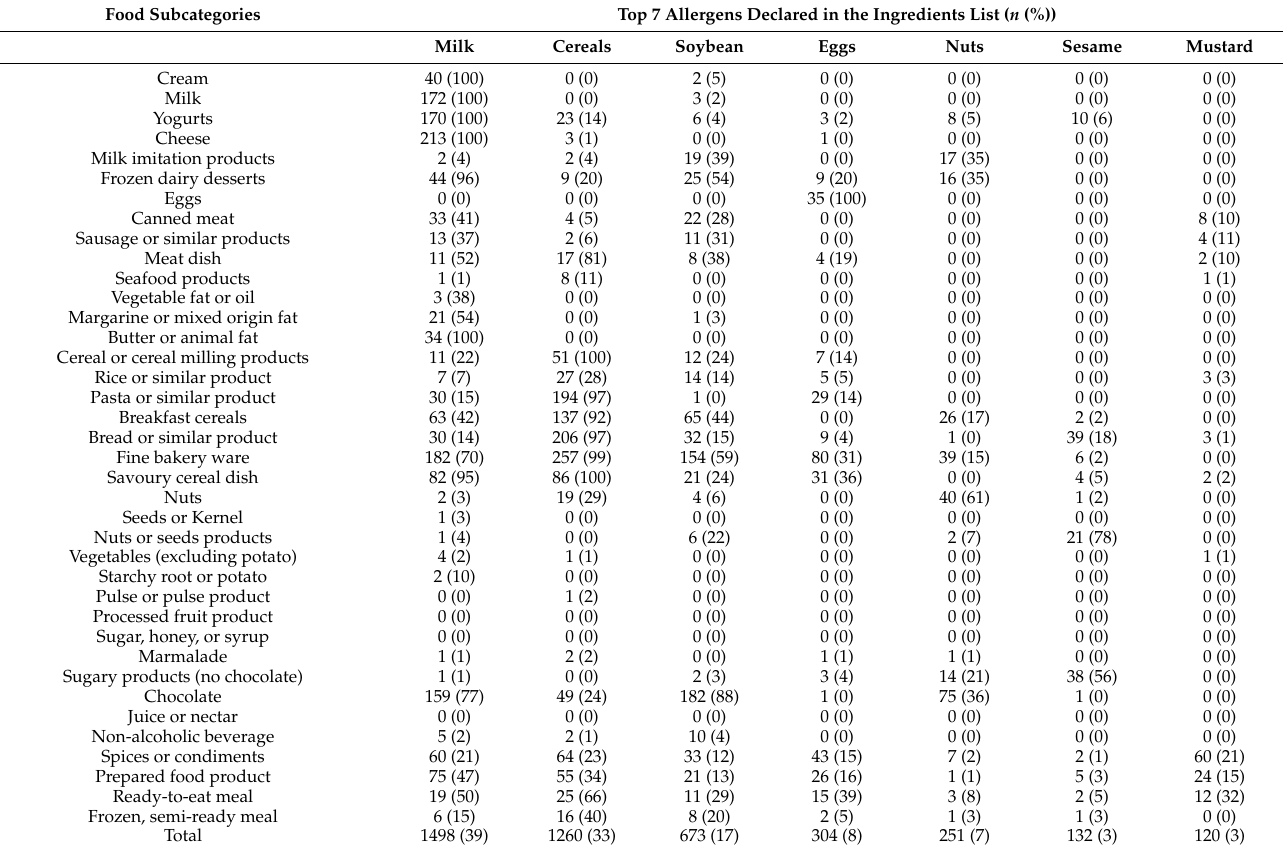
Table 3. Prevalence of the most commonly declared allergens in the ingredient list among